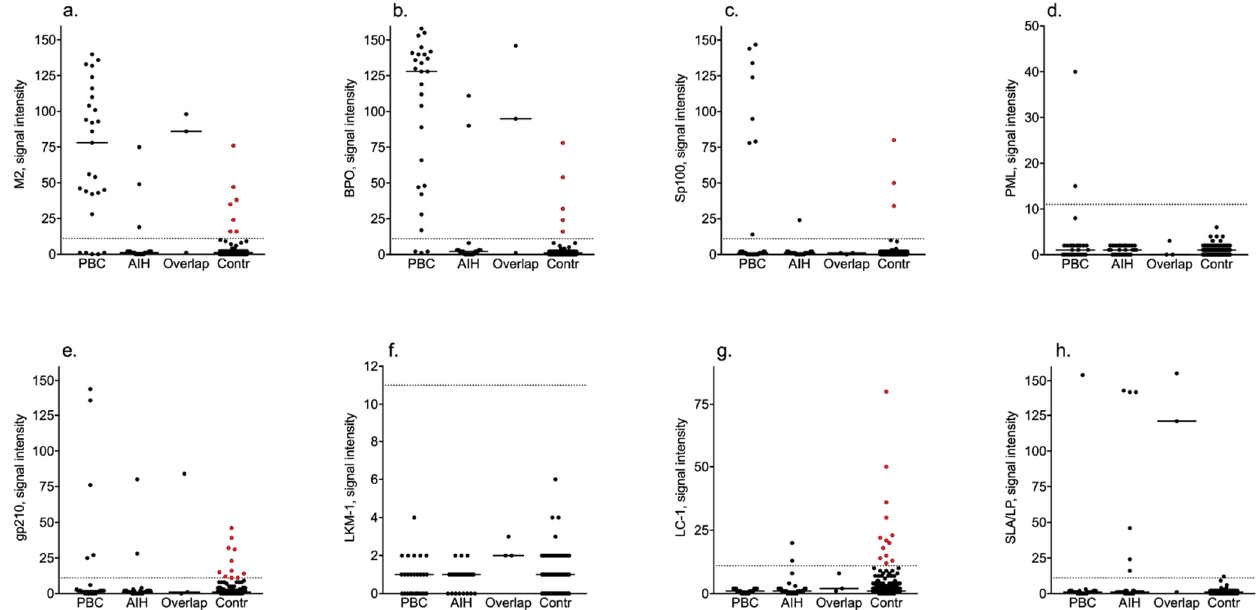
Figure 1. Signal intensity values of specificities in the blood donor and disease cohorts. Red dots indicate controls with signal intensity values above the manufacturer’s cut-off. PBC, primary biliary